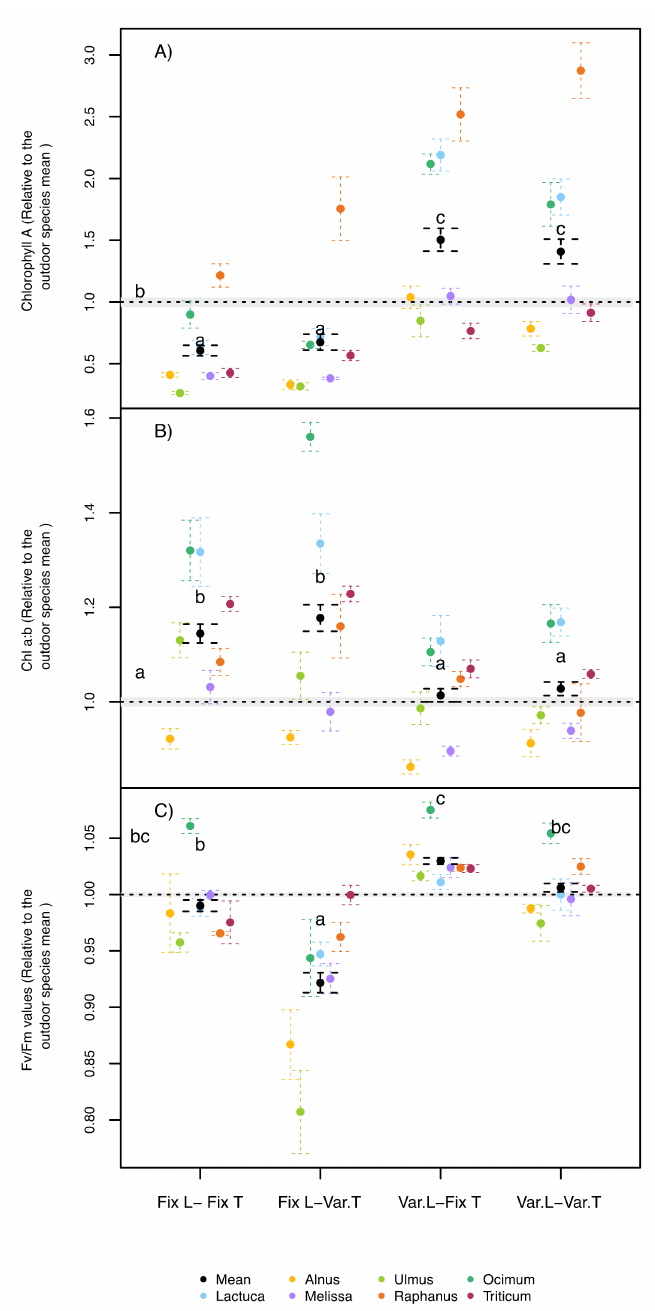
Figure 3. ( A ) Chlorophyll a leaf concentrations, ( B ) leaf chlorophyll a to b ratios, and ( C ) F v /F m values of seven different species normalized to an outdoor control treatment under four treatment combinations (fixed, Fix., or variable, Var.) of two environmental factors (light, L, and air temperature and humidity, T). Error bars correspond to the standard error. N = 3 for each species, where N for the average = 21. Different letters indicate significant differences ( p < 0.05, by Tukey post hoc tests) among treatments (including the outdoor trials) using species as random